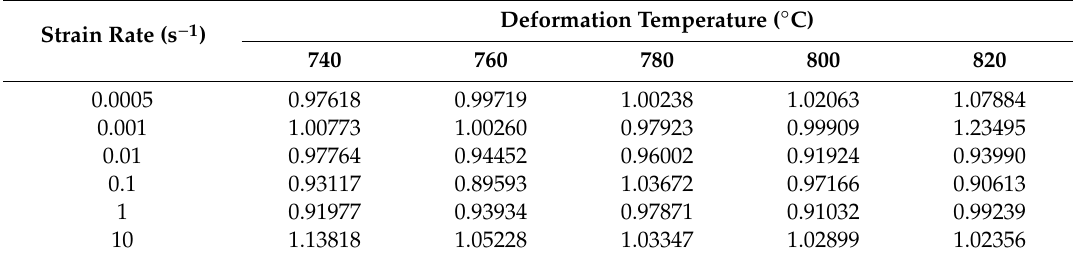
Table 3. The values of the material constant, ζ 1 , under all of the tested specified loading conditions.